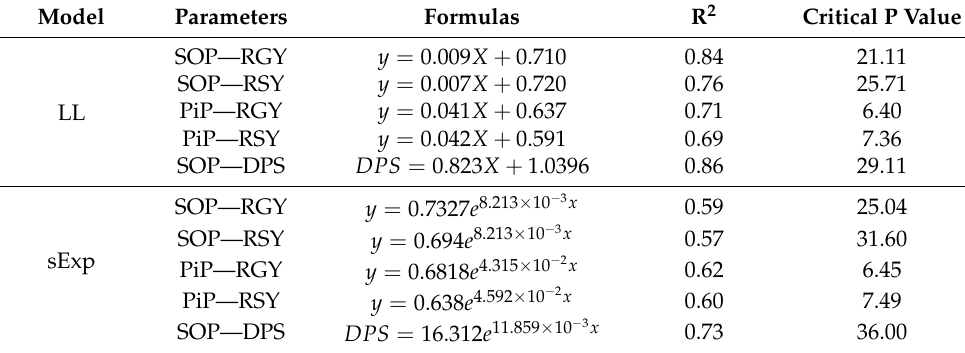
Table 5. Critical P values in soil (SOP) and plant tissue (PiP) calculated for grain (RGY) and straw (RSY) yields and degree of phosphorus saturation (DPS) fitted by the linear–linear (LL) and exponen- tial models (Exp) under the four growing seasons ( n = 176). R 2 correlates X (critical P value) and Y (relative yield). Critical P values are in mg kg − 1 for soil and g kg − 1 in